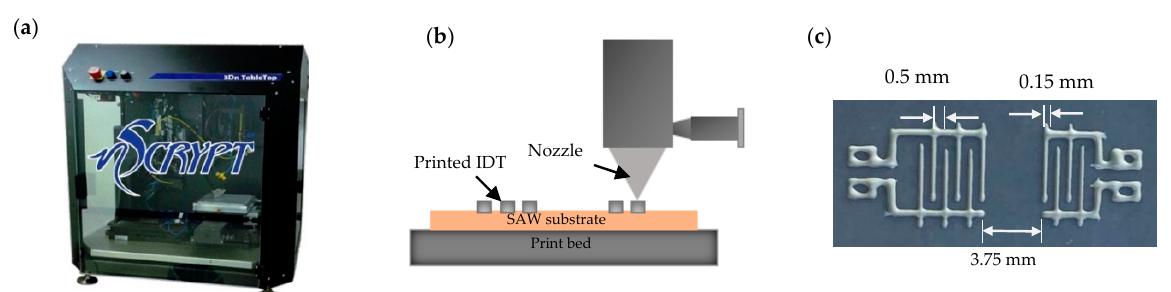
Figure 2. ( a ) 3Dn series tabletop printer. ( b ) Micro-dispensing schematic of printing conductive electrode. ( c ) Printed IDT with dimensions.